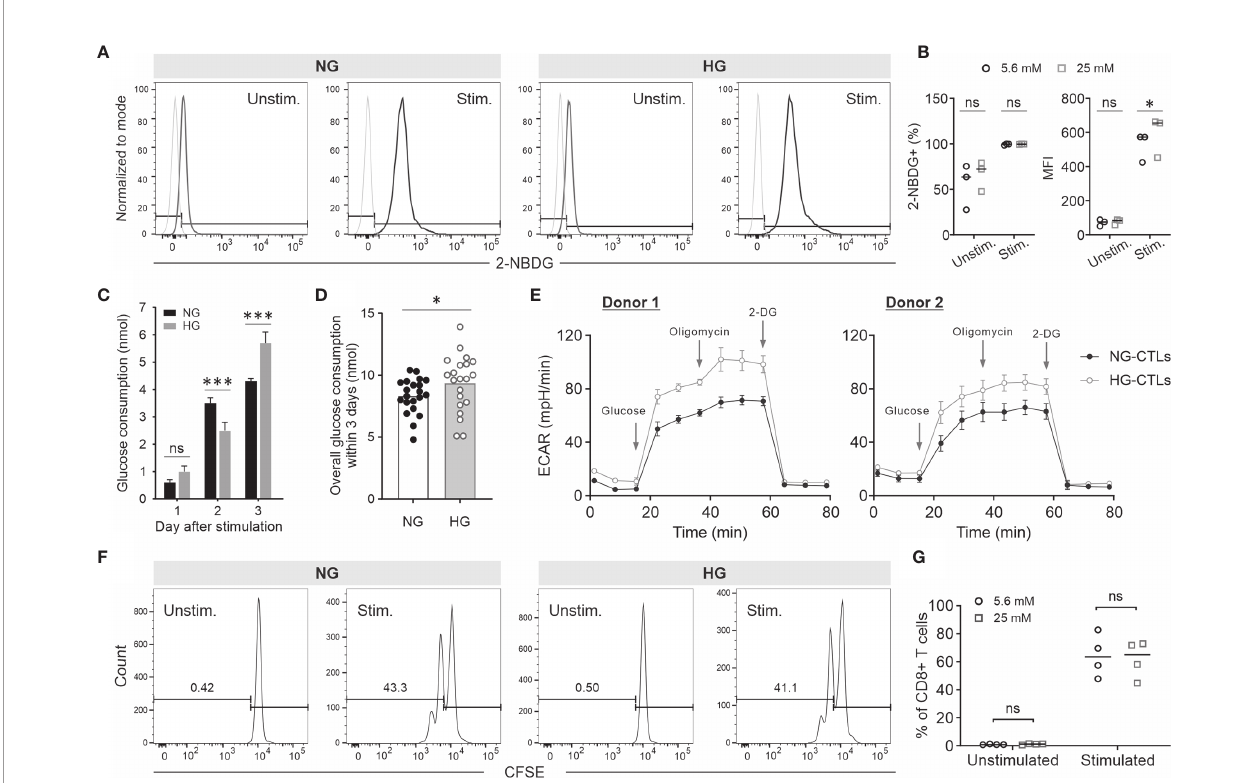
FIGURE 1 | Impact of HG culture on glycolysis and proliferation of CTLs. Primary human CD8+ T cells were stimulated with anti-CD3/CD28-antibody coated beads in medium containing NG (5.6 mM) or HG (25 mM) for 3 days. (A, B) Glucose uptake in NG- and HG-cultured CTLs. On day 3, bead-stimulated (stim.) or unstimulated CD8+ T cells (Unstim.) were loaded with 2-NBDG at 37°C for 30 min and analyzed with fl ow cytometry. FMO for gating is shown in light grey in (A) . Fraction of 2-NBDG+ cells and mean fl uorescence intensity (MFI) is shown in (B) . (C, D) Glucose concentration was measured at indicated time points using blood glucose meter (Bayer). Glucose consumption was calculated for 1.5 × 106 CTLs. (E) Extracellular acidi fi cation rate (ECAR) of CTLs. (F, G) Proliferation of CTLs cultured in NG- or HG-medium. Primary human CD8+ cells were stained with CFSE prior to CD3/CD28 bead-activation. The fl uorescence was determined with fl ow cytometry. Results are from three (A, B) , twenty-two (C, D) , two (E) or four donors (F, G) . * p < 0.05; *** p < 0.001; ns, not signi fi